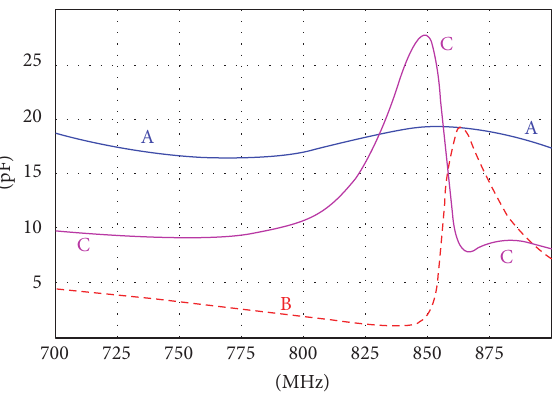
Figure 8: Nominal capacitances of the adjustable impedance devices which realize C 𝐴 in the lossy MAPMUP antenna tuner of Section 5, versus the tuning frequency: 𝐶 𝐴𝐺 is curve A; 𝐶 𝐴𝑁 is curve B; and 𝐶 𝐴𝐹 is curve C.